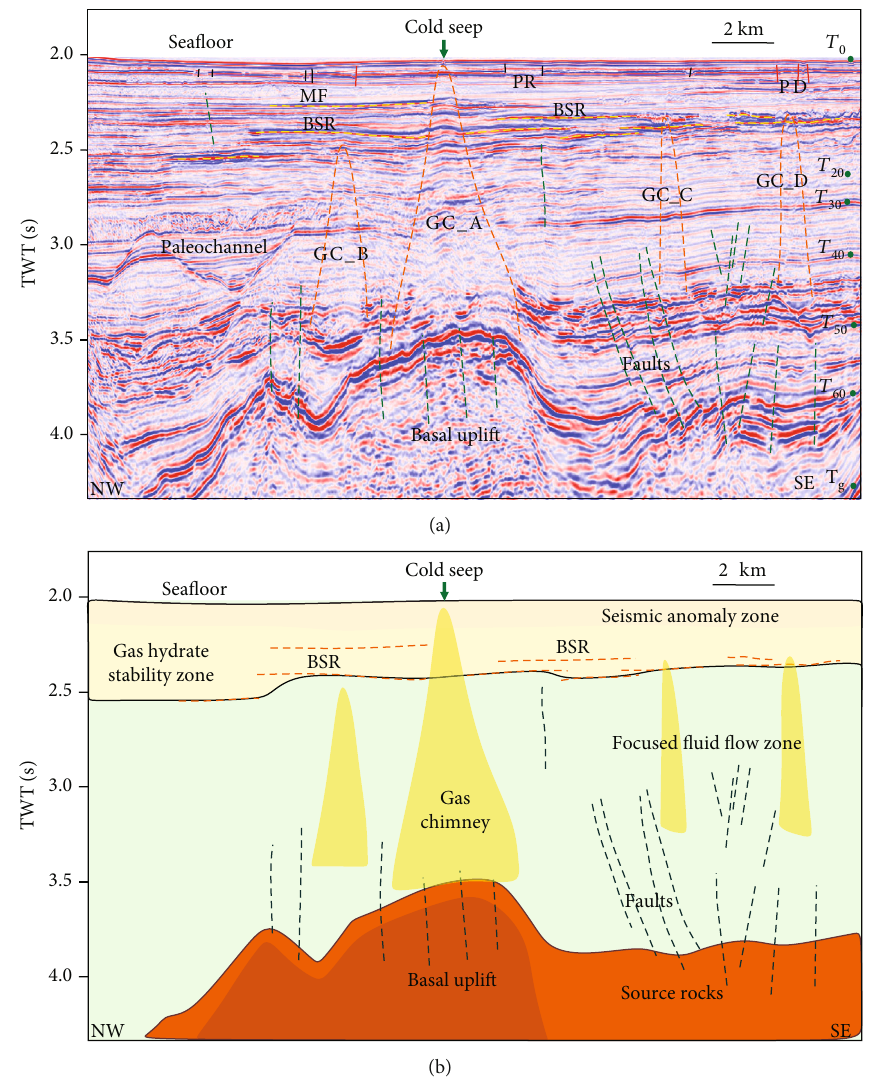
Figure 8: (a) Seismic section of the deep gas chimneys, BSRs, and newly discovered cold seeps in the study area and (b) schematic diagram of the gas generation, migration, and accumulation in the study area. The yellow dashed lines in panel (a) indicate the BSRs, the orange dashed lines delineate the gas chimneys, and the olive green lines indicate the faults. The orange area in panel (b) represents Eocene-Oligocene source rocks, and the yellow cones represent gas chimneys; the light green area represents the gas migration zone. The BGHSZ is indicated by BSRs, and the top area is the seismic anomaly area, which is also characterized by focused fl uid fl ows and shallow gas hydrates. PR: polarity reverse; PD: pulldown; MF: minor fault; GC: gas